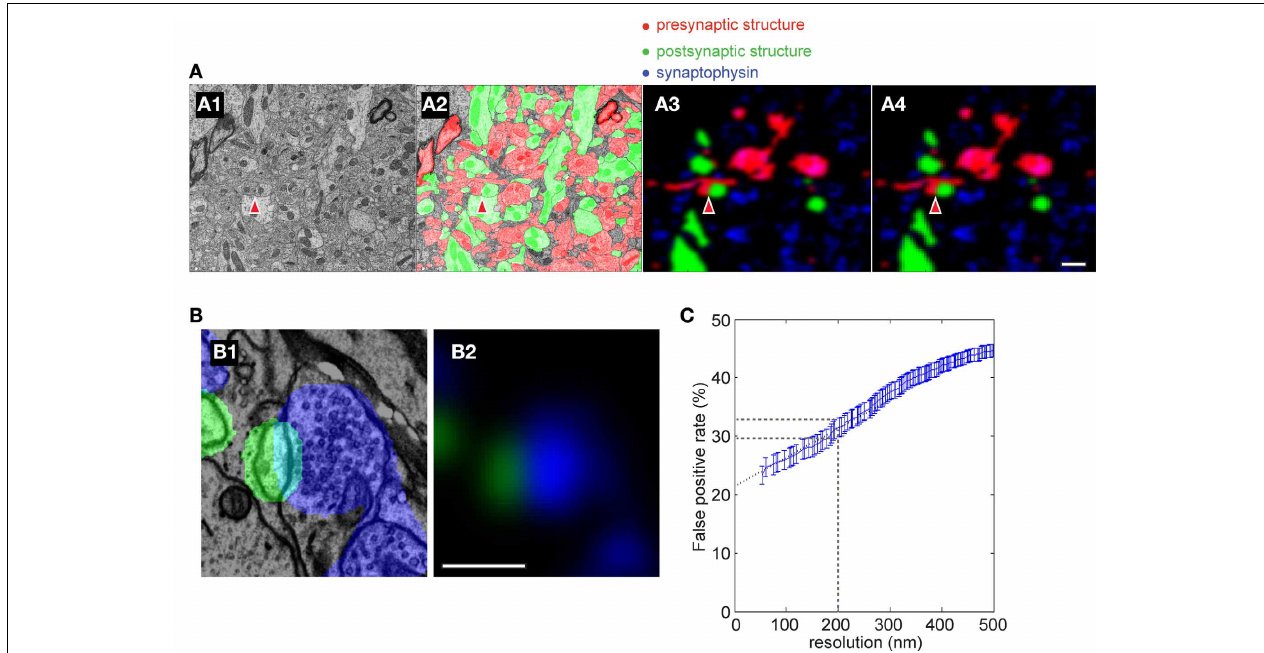
FIGURE 7 | Simulation of accuracy of synapse detection by AT. (A) Simulated AT images using a previously segmented EM image data set [from Mishchenko et al. (2010)]. (A1) an example EM image; (A2) same image segmented into pre- and post-synaptic structures; (A3) segmented image was blurred to produce the same resolution as in the light microscopy of AT with 90% of structures removed to mimic the sparseness of fluorescent labeling of the AT images; (A4) The pixel size of A3 was adjusted to produce the same image as in the light microscopy in AT. Red indicates presynaptic structures, green postsynaptic, blue